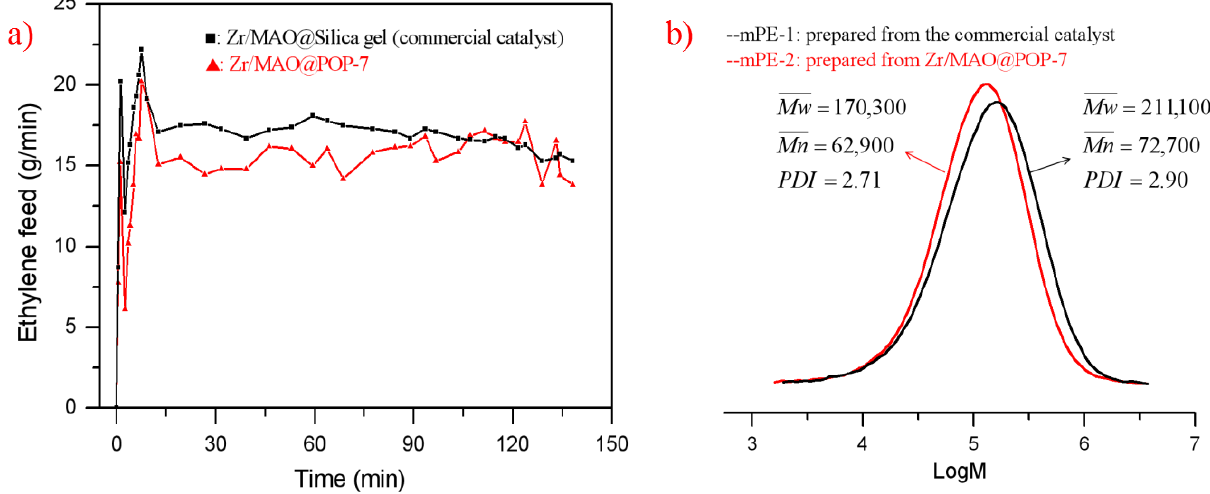
Figure 8. ( a ) Kinetic curves of ethylene polymerization. 0.83 g Zr/MAO@Silica gel was evaluated at 80 °C in 10 bar ethylene pressure; 0.67 g Zr/MAO@POP-7 was evaluated at 80 °C in 6 bar ethylene pressure. ( b ) GPC curves of two mPEs from the two catalysts.